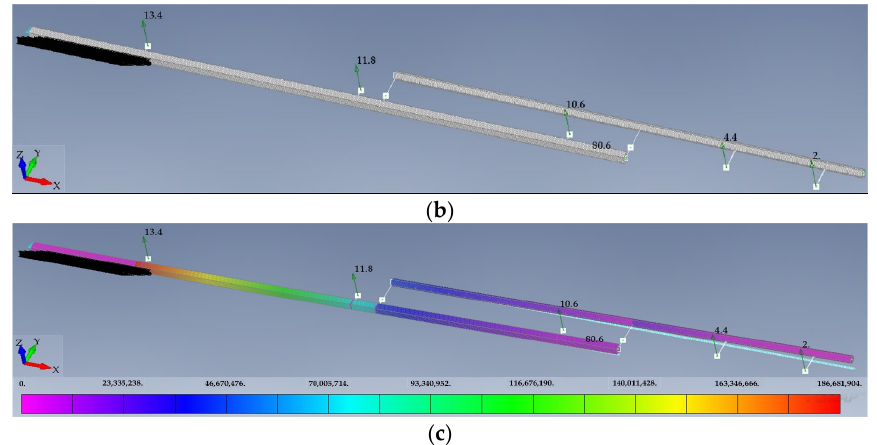
Figure 7. FEM models of main and overlapping spars: ( a ) Schematic of spar analysis. ( b ) Spars before deformations. ( c ) Spars after deformations (shows combined stresses in Pascal).